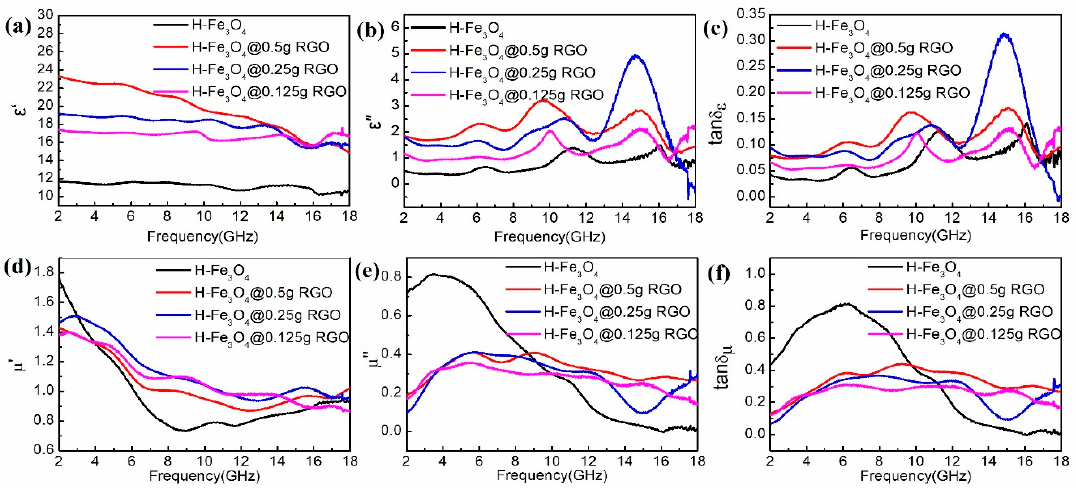
Figure 5. Real part of the relative complex permittivity ( a ); imaginary part of the relative complex permittivity ( b ); electric loss tangents ( c ); real part of the relative complex permeability ( d ); imaginary part of the relative complex permeability ( e ); and magnetic loss tangents of the prepared composites ( f